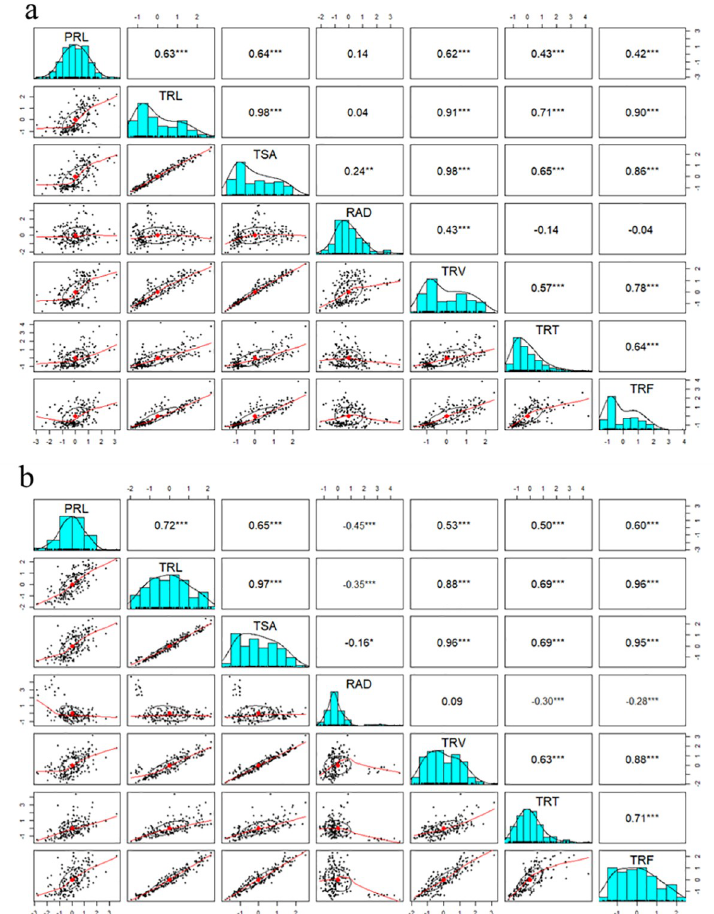
Fig 2. Relationship between measured root traits, their significance levels and distribution among wheat genotypes under non-limiting (NLP) (a) and limiting (LP) phosphorus (b) conditions. https://doi.org/10.1371/journal.pone.0255840.g002 of genotypes fell in LP were for PRL (12.64%) and RAD (4.40%). More interestingly, under LP conditions, more number of highest performing genotypes found for root traits, TRL (23.08%) and TSA (21.43%). The rate of genotypes falling in the low and high performing category have been presented in (Table 4). The Shannon-Weaver diversity index (H’) was calculated to investigate the diversity between the RSA traits in diverse wheat genotypes (Table 4). The H values for the PRL, TRL, Table 3. Root diameter intervals and respective percentage distribution of root traits of wheat genotypes under both non-limiting and limiting phosphorus conditions. Traits TRL (%) TSA (%) TRV (%) TRT (%) Treatments Subclass NLP LP Subclass NLP LP Root diameter class